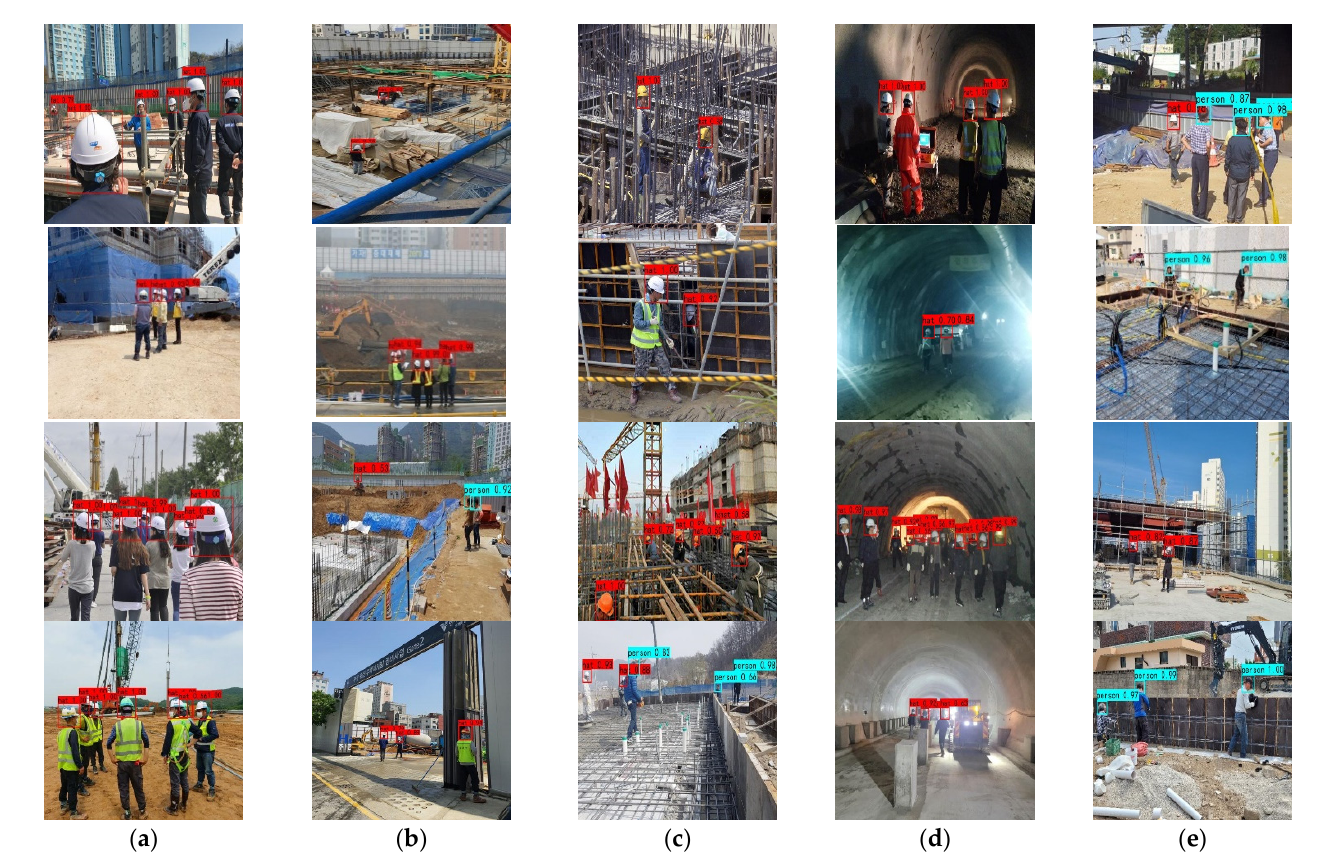
Figure 13. Using the detection examples of our model on construction sites, we show the results for detections with scores above 0.5, with each color corresponding to an object class (red for helmeted, blue for unhelmeted, and the values on the bounding boxes representing confidence levels). These examples cover many factors, including ( a ) detection results on construction sites, ( b ) longer visual range situations, ( c ) occluded detection, ( d ) insufficient light in the tunnel, and ( e ) different individual